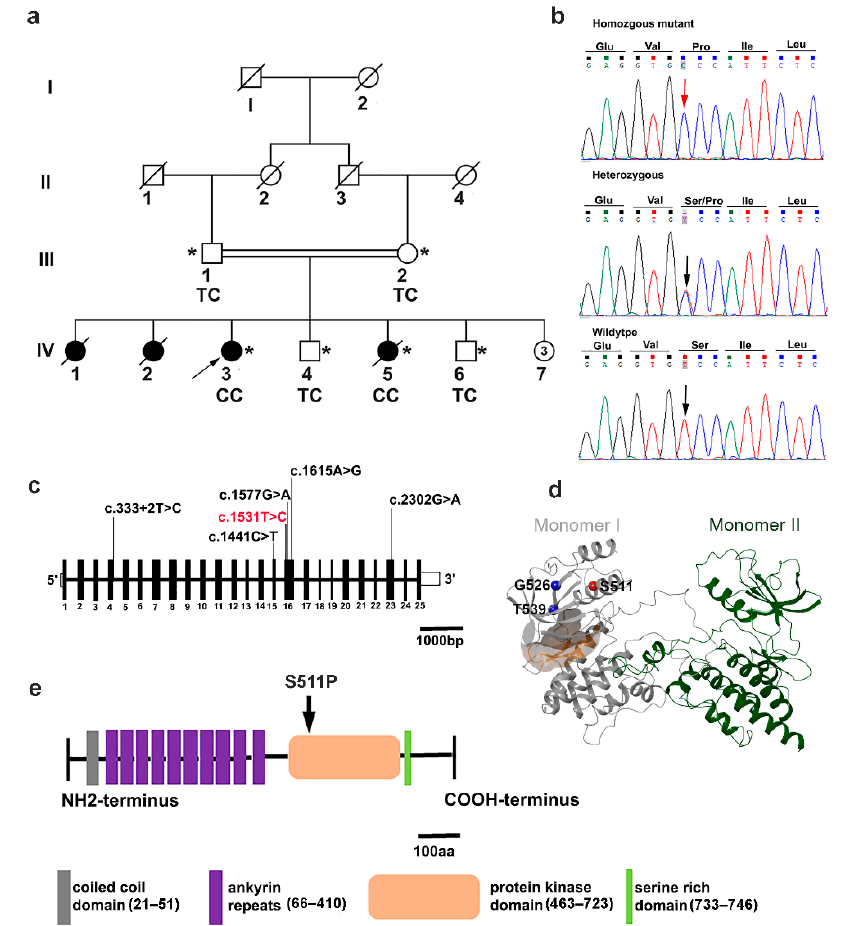
Figure 1. Pedigree, sequencing chromatogram, and location of the TNNI3K variant in the family with cardiac conduction disease (CCD). ( a ) Family pedigree. The open symbols represent unaffected individuals and the filled symbols represent affected individuals; symbols with a diagonal line rep- resent deceased individuals; and the arrowhead designates the proband. An asterisk indicates fam- ily members from whom DNA was available. The genotypes of the TNNI3K mutation are indicated below each examined member: CC (homozygote); TC (heterozygote); number inside the circle de- note the number of individuals. ( b ) Sequencing chromatograms. Vertical arrows indicate the muta- tion site. ( c ) Schematic of the human TNNI3K gene. The positions of coding exons (black) and UTRs (white) are indicated. Black arrows indicate previously reported pathogenic variants and the red arrow shows the novel variant c.1531T>C in exon 16. ( d ) Initial 3D structure of TNNI3K-WT (PDB- ID: 4YFI [29]) shown as a ribbon. Monomer I is shown in gray and monomer II in green. The C α atoms of Ser511 (red), Gly526 (blue), and Thr539 (blue) of monomer I are shown in spheres relative to the ATP-binding pocket (orange surface) of monomer I. Gly526 and Thr539 are known TNNI3K missense variants. (e) TNNI3K protein domain structure. Coiled coil domain (gray); functional ankyrin repeat domains, ANK1–ANK10 (purple); kinase domain (orange), where the homozygous mutation p.Ser511Pro resides (arrowed); and a serine-rich domain (spring green). 2.2. Whole Exome Capture and Sequencing WES of two of the affected individuals (IV-3 and IV-5), their non-affected siblings (1V-4 and IV-6), and their parents (III-1 and III-2) (Figure 1a) were carried out at the Co- logne Center for Genomics (CCG, University of Cologne, Cologne, Germany). A genomic DNA sample (1 µg) was sheared by fragmentation (Covaris, Woburn, MA, USA) and pu- rified for library preparation using Agencourt AMPure XP beads (Beckman Coulter, Fullerton, CA, USA) following the manufacturer’s protocol. Enrichment was carried out using the Agilent SureSelect Human All Exon V6 r2 kit (Agilent Technologies, Santa Clara,